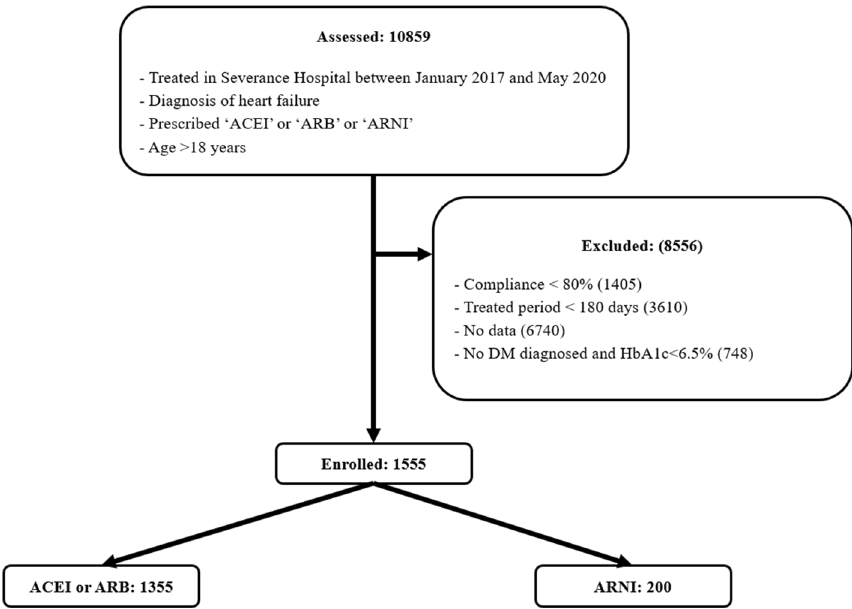
Figure 1. Flowchart of patient inclusion and exclusion criteria.